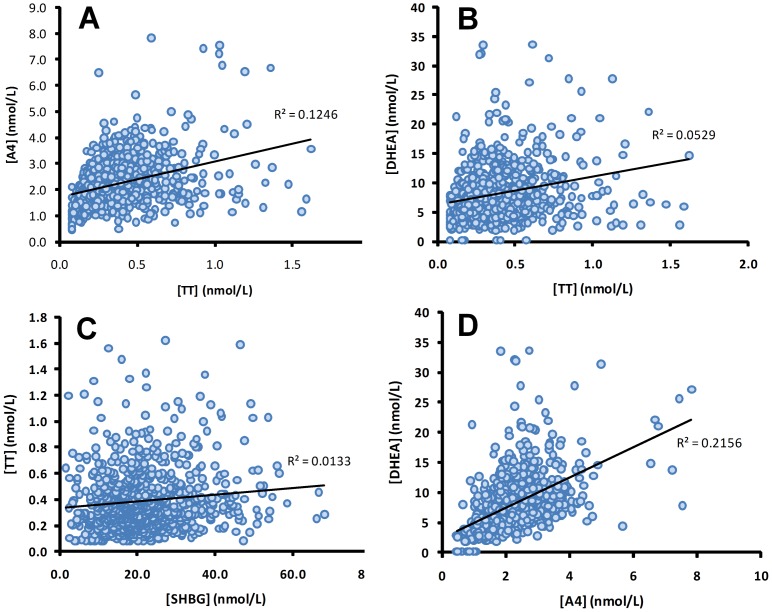
Linear regression analysis of cord androgen and SHBG concentrations in 803 neonates (males and females combined).The linear regression coefficients (R2) are indicated on each graph. All correlations were statistically significant (A, B and D: P<0.0001; C: P<0.0005) and remained significant after controlling for multiple maternal and obstetric factors in multiple regression analysis.